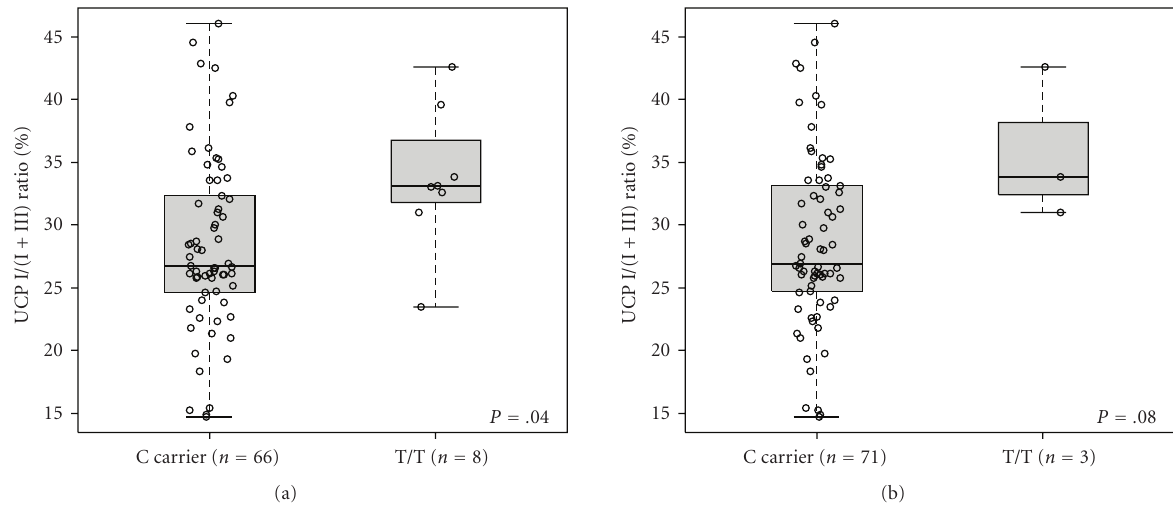
Figure 4: Relationship between UCP I/(I + III) ratio and ABCC2 genotypes [(a) 3972C/T and (b) − 24C/T]. Boxes represent the 25th and 75th percentiles. The median is indicated by a line, and the 10th and 90th percentiles are indicated by